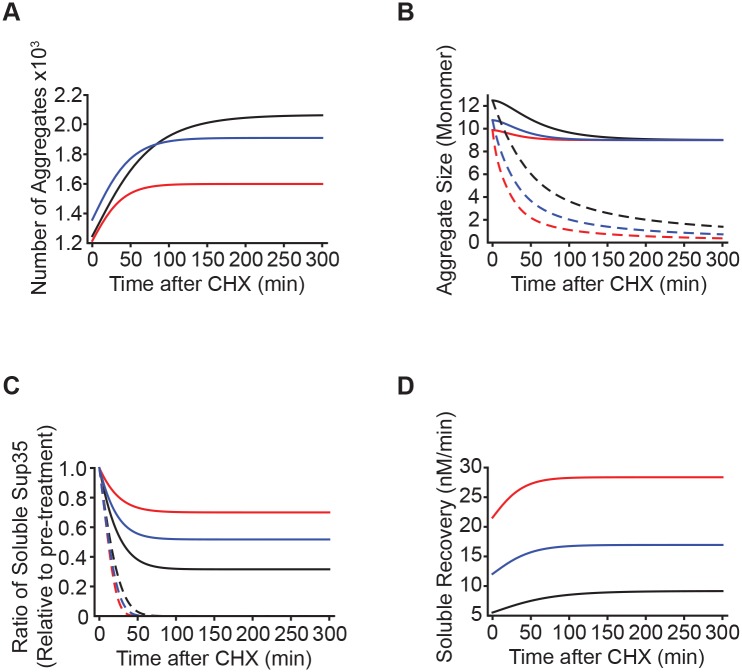
Mathematical model predicts fragmentation-dependent changes in soluble Sup35 levels in response to protein synthesis inhibition.Cycloheximide (CHX) treatment leads to an increase in the number of aggregates (A), an increase in average aggregate size (B), and a decrease in the ratio of soluble Sup35 (C) according to the results of stochastic simulations of a mathematical model of prion propagation. The yields (A, C) and the rate at which protein resolubilizes (D) vary with the rates of fragmentation: high (red), medium (blue), or low (black). The predicted changes in Sup35 average aggregate size (B) and soluble levels (C) are lost when nucleation is removed from the model (dashed lines).